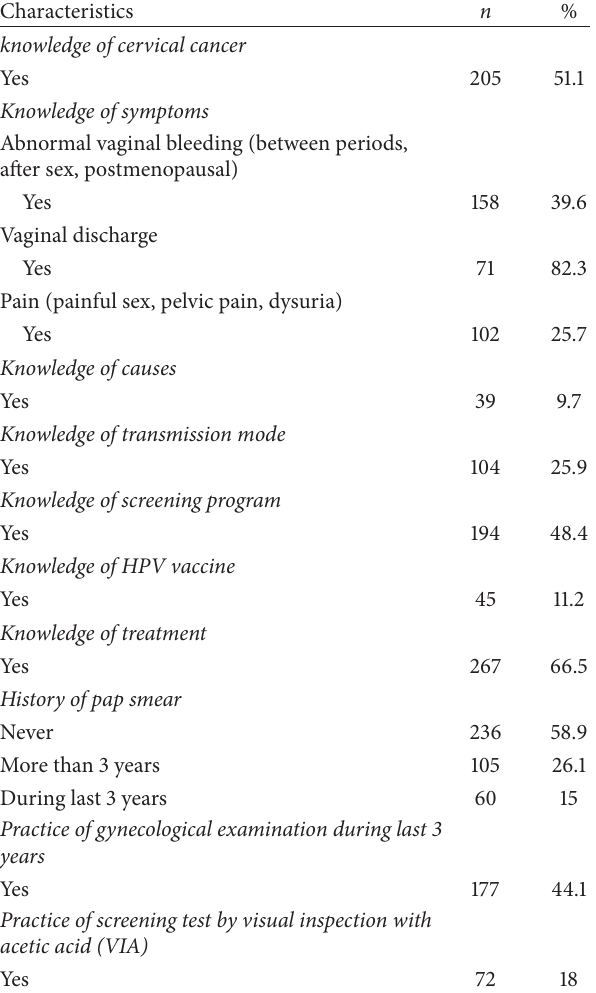
Table 2: Description of knowledge and practice in cervical cancer ( 𝑛 = 401